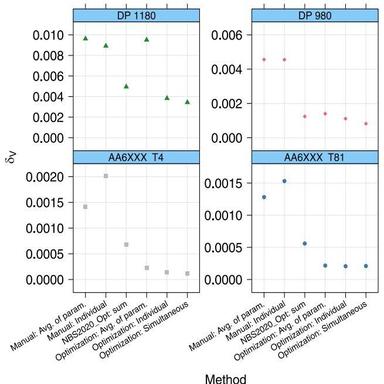
Total residual (normalized), δV, for the four alloys, separated by Method and the variant ("Method: variant") used to compute it.